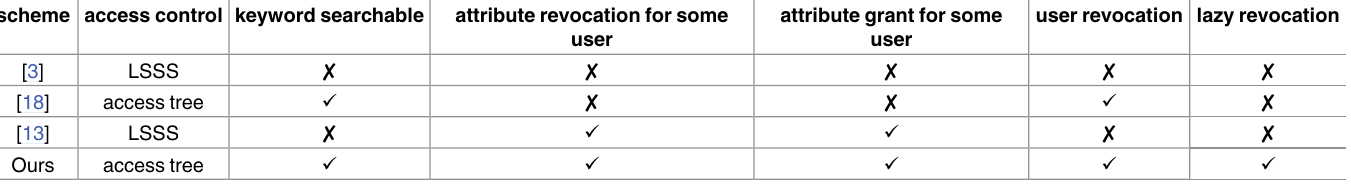
Table 1. Comparisons of Our Scheme with the Main References. scheme access control keyword